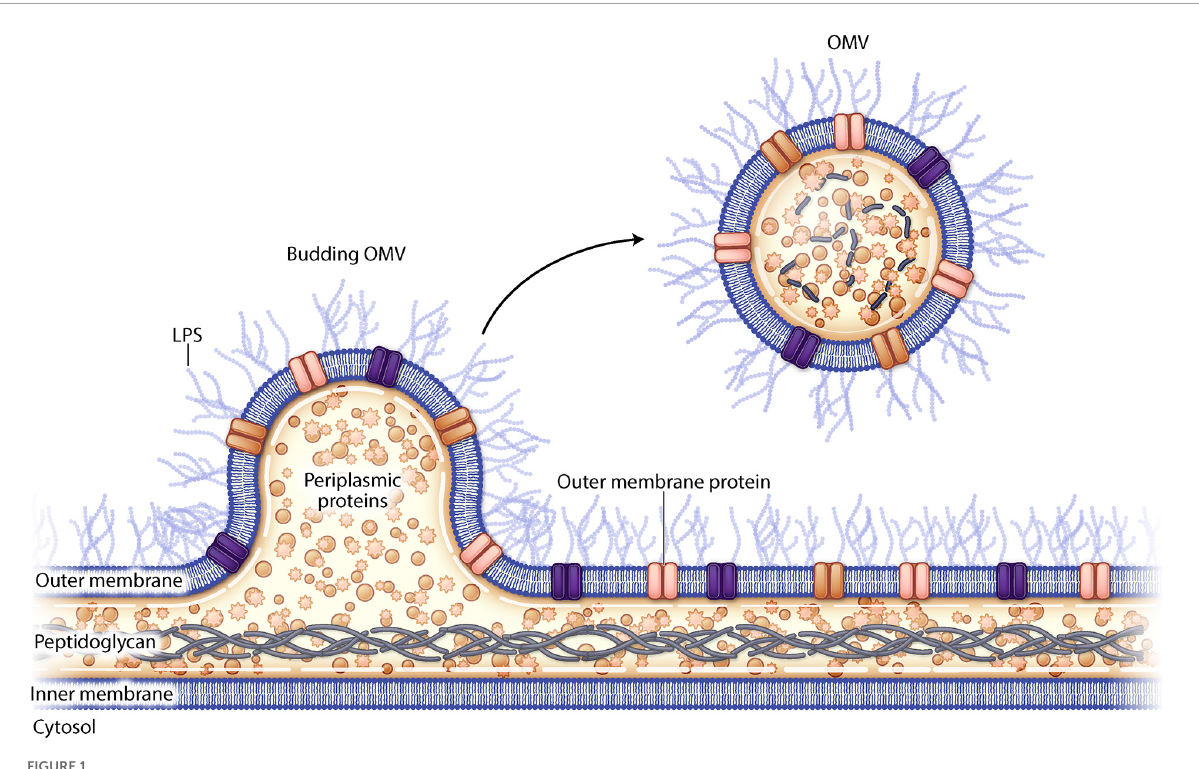
FIGURE1 Schematic drawing of outer membrane vesiculation from a gram negative bacterial cell